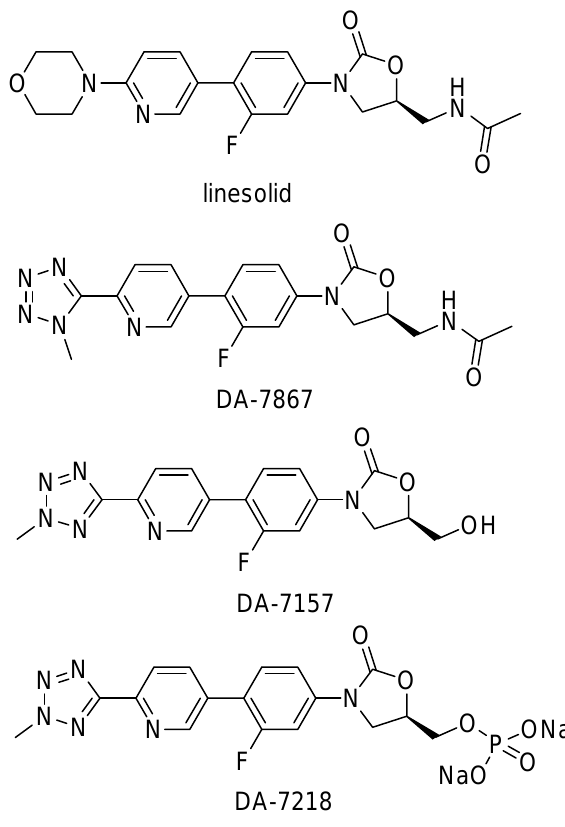
Figure 43. Chemical structures of oxazolidinone